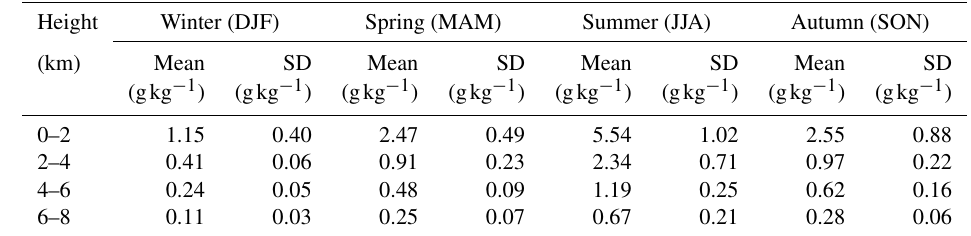
Table 3. Seasonal mean values of WVMR for different atmospheric layers and their SD as calculated from the lidar. Height Winter (DJF) Spring (MAM)